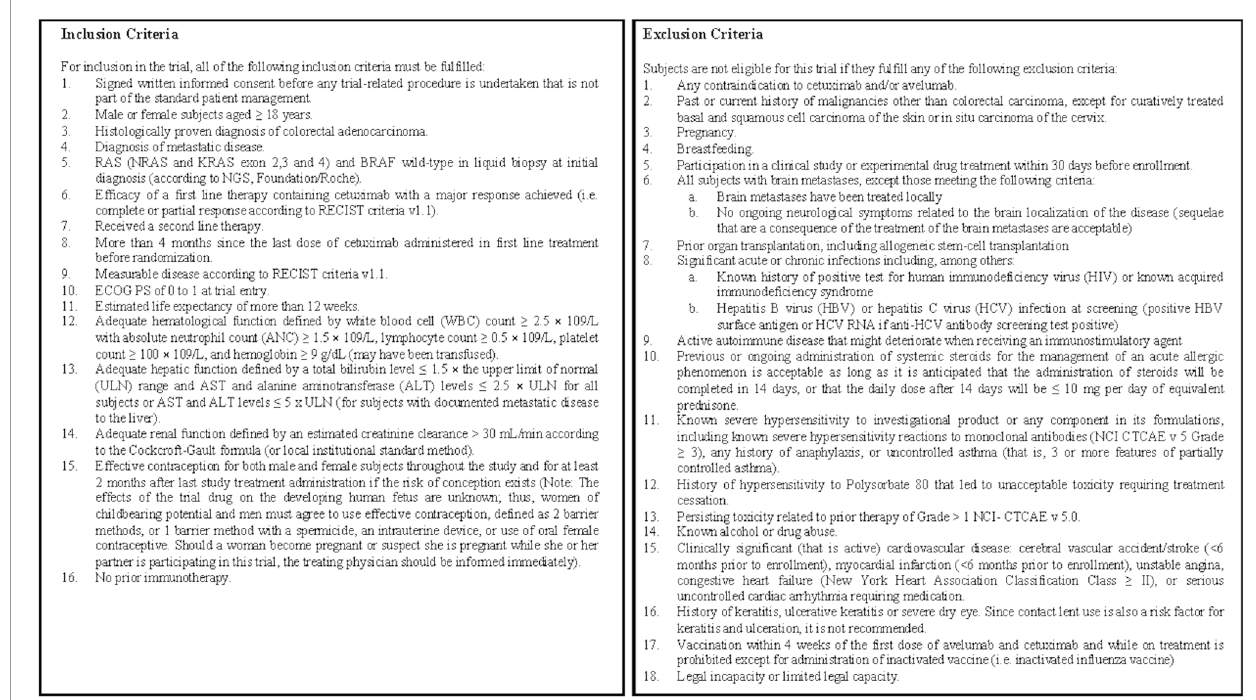
FIGURE 3 | Inclusion and exclusion